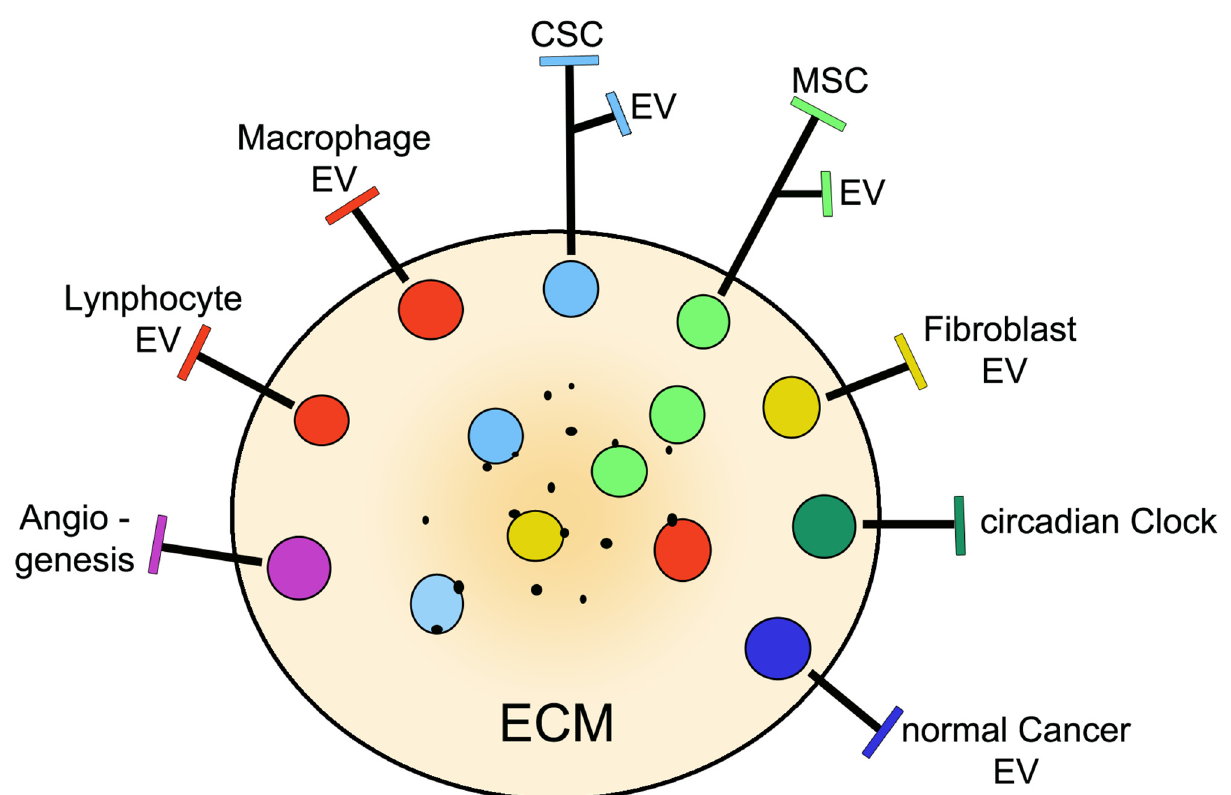
Figure 2. Drawing of a tumor microenvironment (TME) with reference to various types of cells, their processes, and their functions. The extracellular matrix (ECM) documents properties of the cancer environment, which is important for direct interaction with the cells. The apparent connection between the images close to the external line and their names, permits one to distinguish the nature of the present cells. The two stem cells, cancer (CSC, light blue) and mesenchymal (MSC, green), are located at the top and top right. Among the other cells, normal cancer cells, which are highly abundant in their masses (not shown), are known to differ considerably from CSCs. Fibroblasts, macrophages, and lymphocytes are filtered cells that contribute to the TME activity by their cooperation in cancer-protective and cancer-associated processes. All cells produce, by secretion, their extracellular vesicles (EVs). The highly functional and molecular relevance of the vesicles from the two stem cells are suggested by the close location of their EV to the name of their cell of origin. Cells mentioned so far, labeled by the same colors, are present also in the central area of the image. The dots at the surface of the cells are EVs in continuity, possibly involved in release or fusion, which are the processes of molecular transfer between cells. The terms angiogenesis and circadian clock do not describe single cells, but instead are complex processes taking place in TMEs. They require the cooperation of CSCs with various cooperating cells.